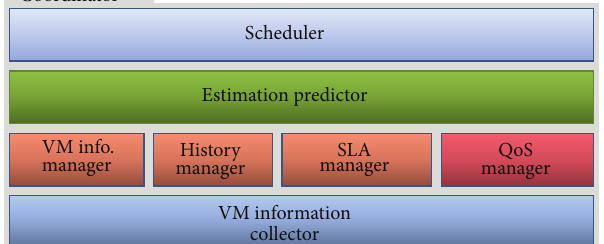
Figure 2: Cloud computing environment.